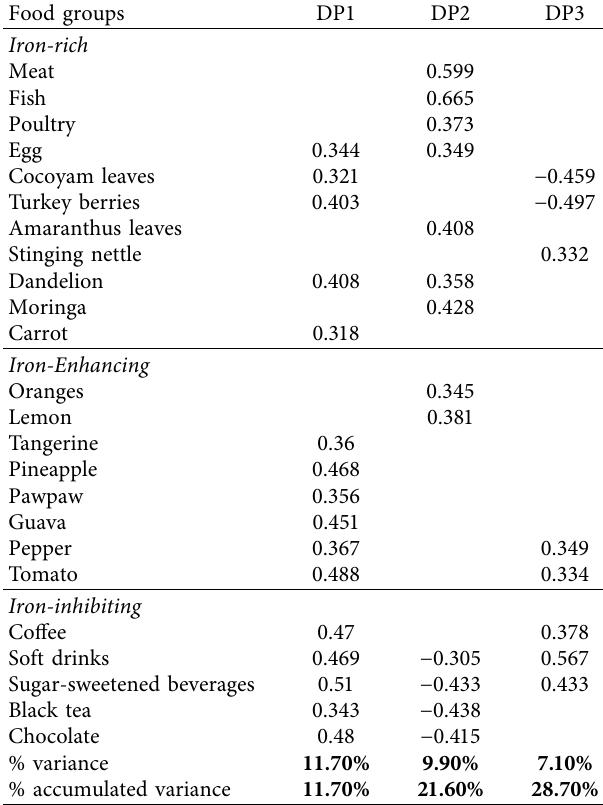
Table 2: Principal component analysis of dietary pattern (DP) of iron-rich food